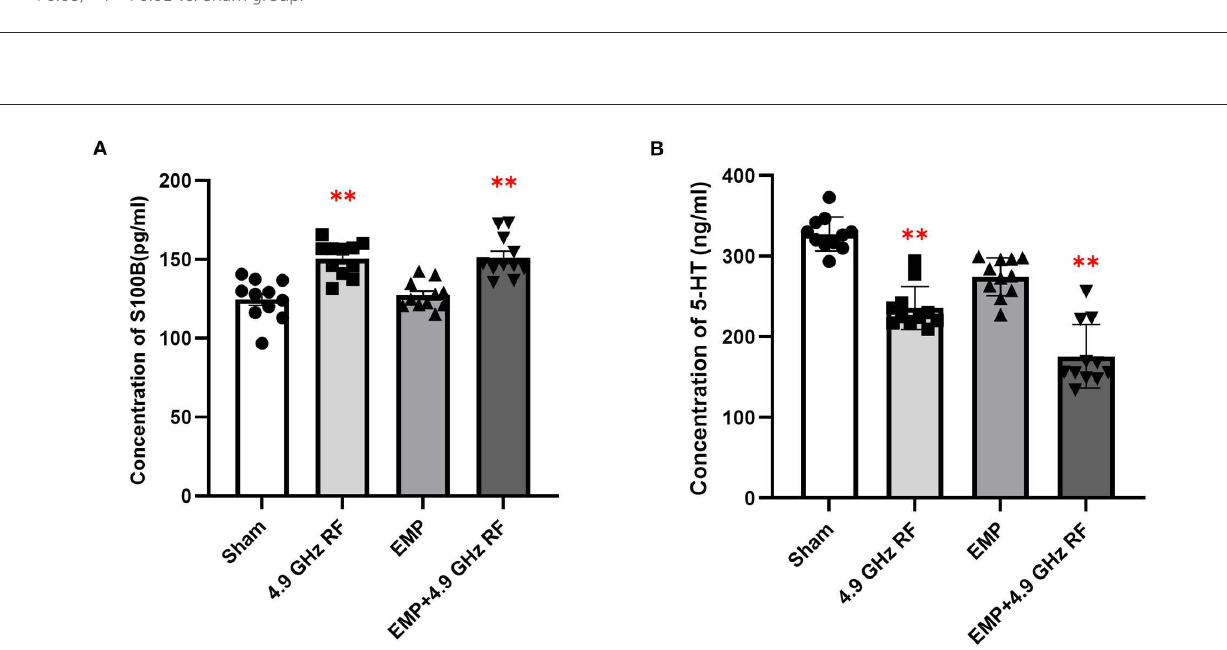
FIGURE5 Effects of combined exposure to EMP and 4.9 GHz RF on the levels of S100B and 5-HT in serum determined by ELISA. (A) The concentration of S100B in serum. (B) The concentration of 5-HT in serum. n = 11 for each group. ** P < 0.01 vs. Sham group.